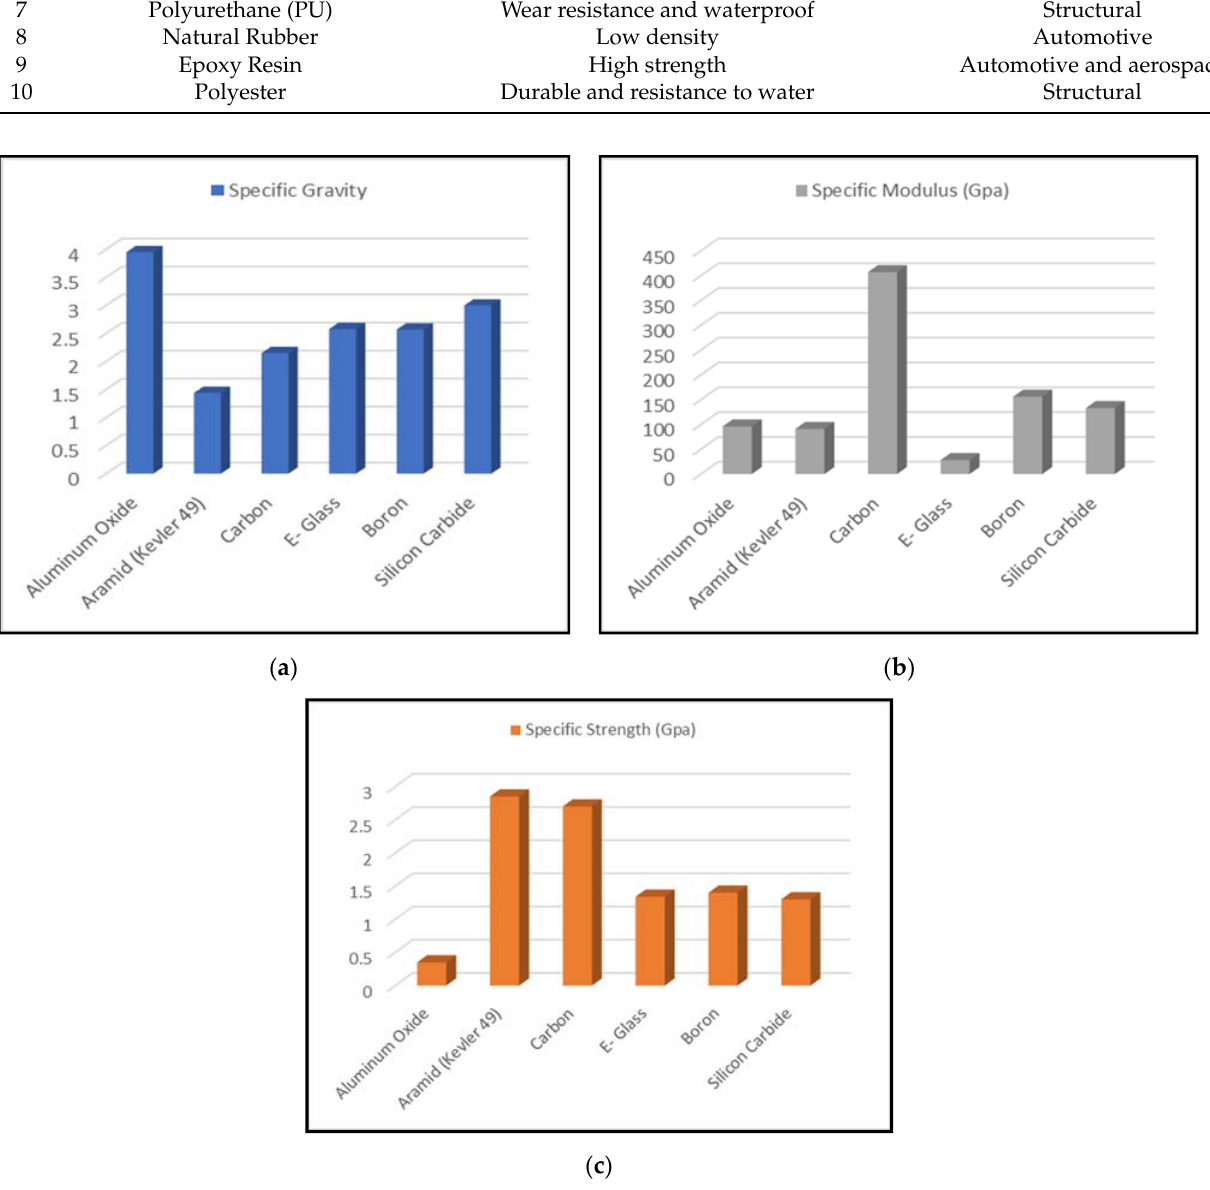
Figure 9. Comparison of different commonly used fiber materials: ( a ) specific gravity; ( b ) specific modulus (GPa); ( c ) specific strength (GPa) (based on data from [35]). Table 1. Different properties and industrial applications of matrix materials [30–34].